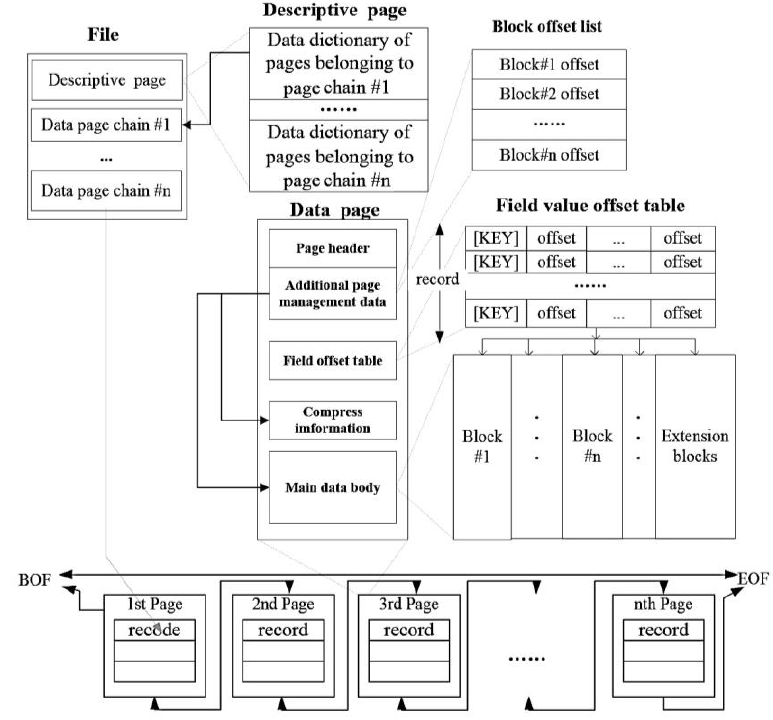
Figure 3. Physical structure of the China Navigation Data Format (CNDF).